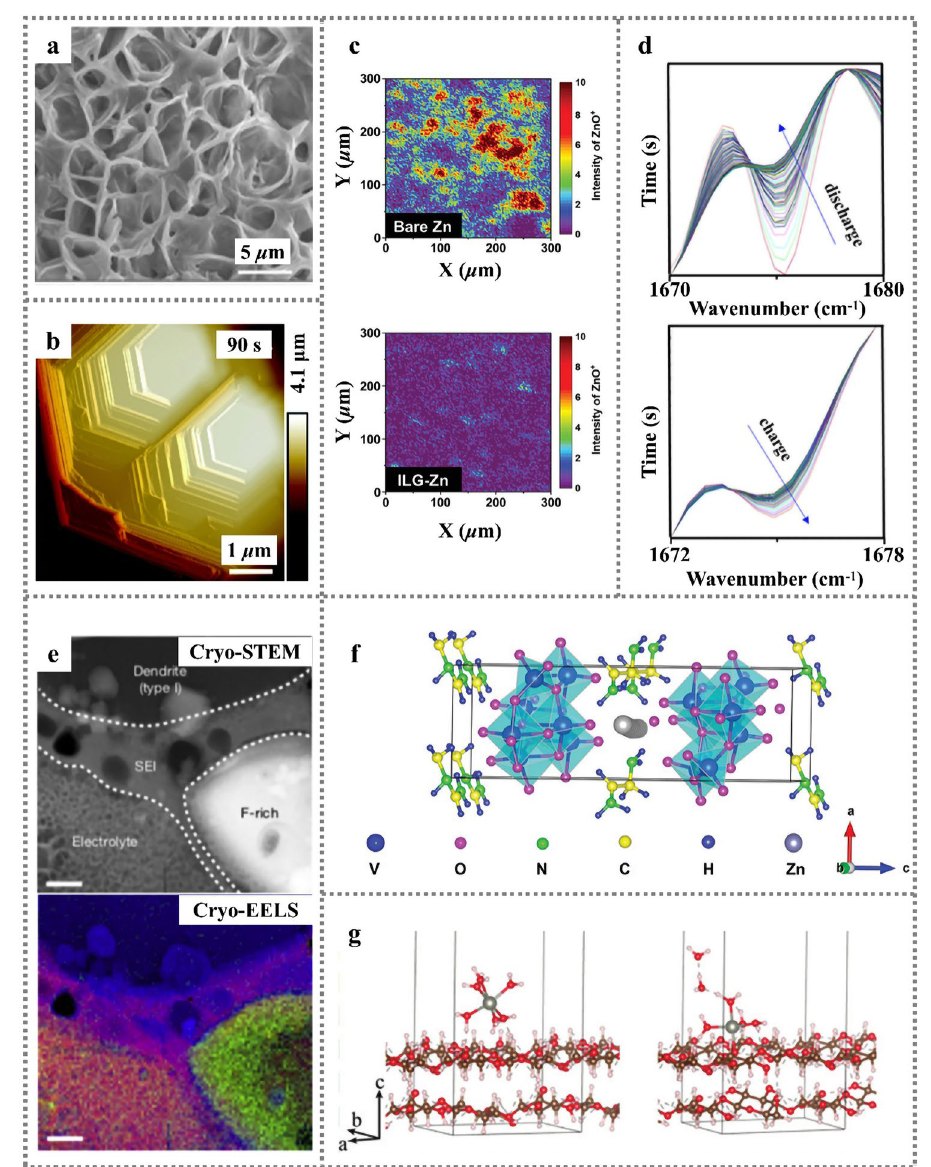
Fig. 5 a SEM images of the morphologies grown at the Zn anode after plating/stripping [59]; Copyright 2019, Wiley–VCH. b In situ AFM images of Zn electrodeposits [61]; Copyright 2021, Royal Society of Chemistry. c TOF–SIMS mapping images (ZnO + species) of the bare Zn (top) and ILG-Zn (bottom) [63]; Copyright 2021, Wiley–VCH. d 2D patterns of in situ ATR-FTIR spectra in first discharge and charge cycle [64]; Copyright 2022, Elsevier. e HAADF cryo-STEM imaging reveals an extended SEI layer on the dendrite, and element distribution in